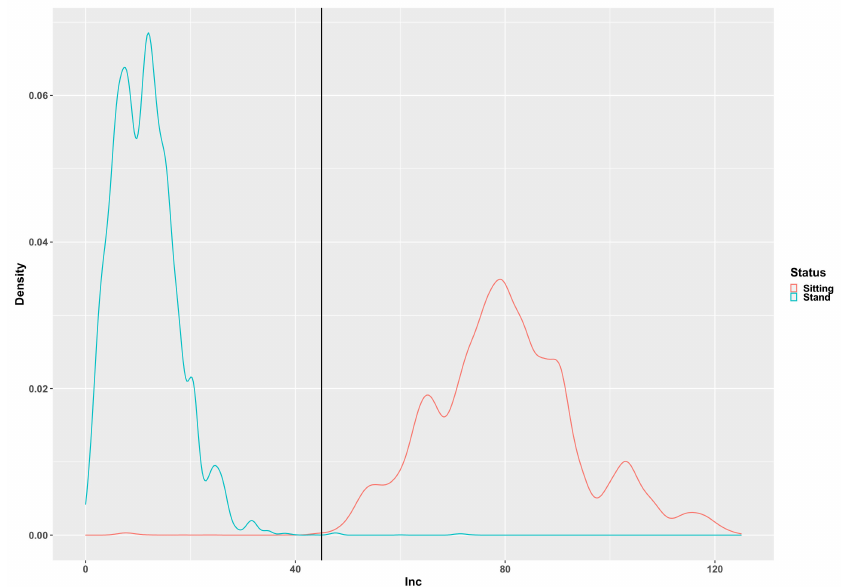
Figure 5. The pooled distribution of the Inc (inclination angle) signal feature for sitting (red curve) and standing (green curve) activities. The vertical line represents the original adult 45.0 degrees